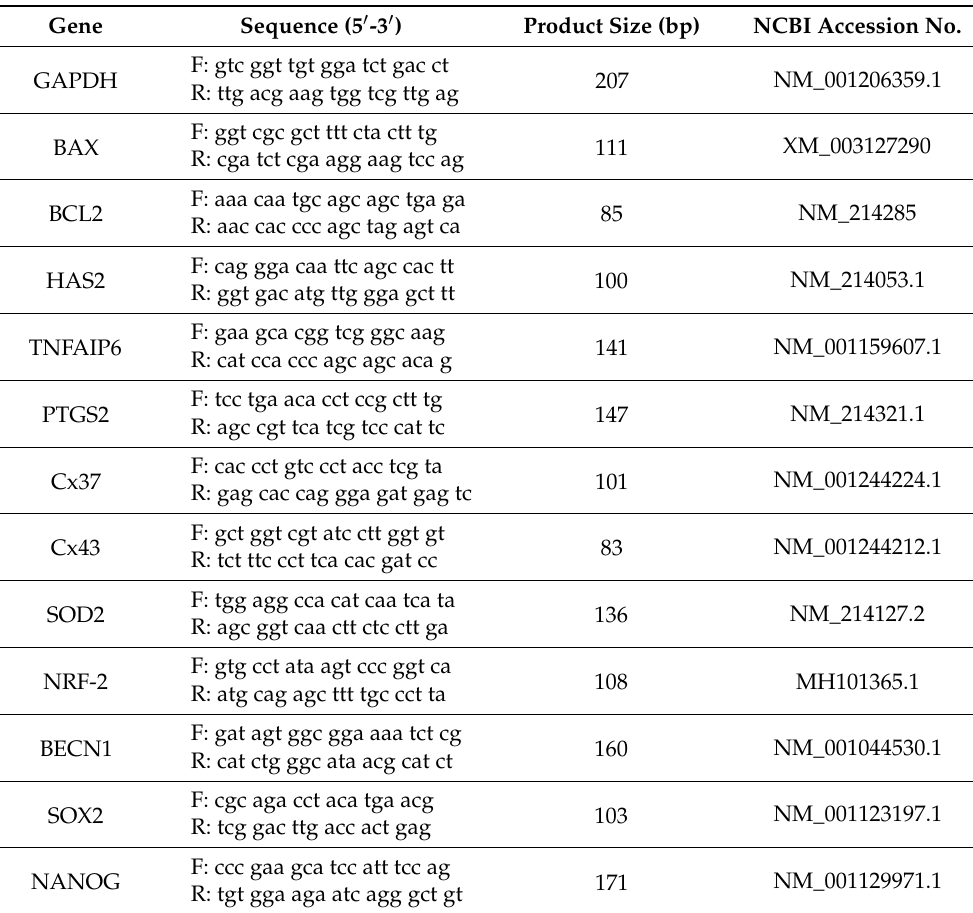
Table 1. Specific primers used for Real-Time